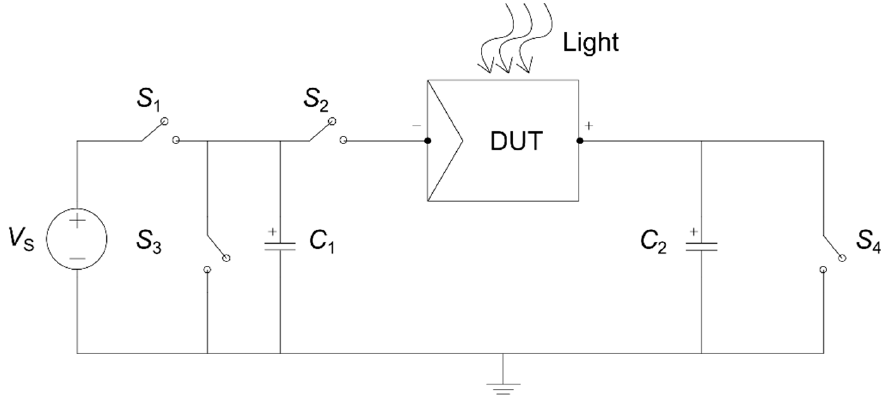
Figure 3. Schematic topology for the proposed I-V tracer. DUT: device under test.